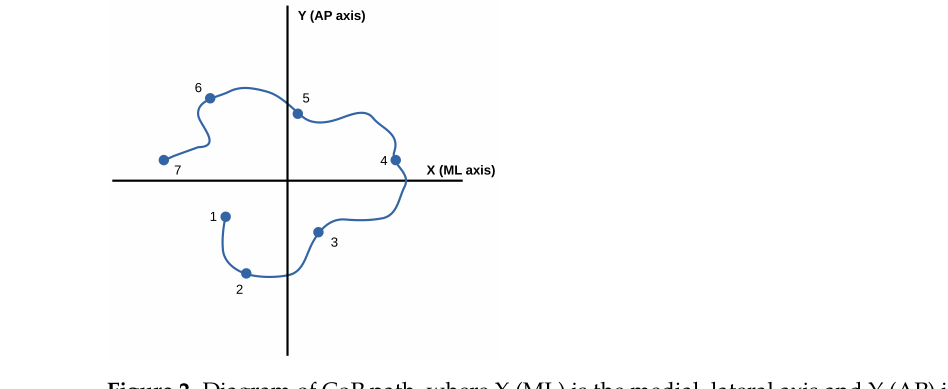
Figure 2. Diagram of CoP path, where X (ML) is the medial–lateral axis and Y (AP) is the anterior– posterior